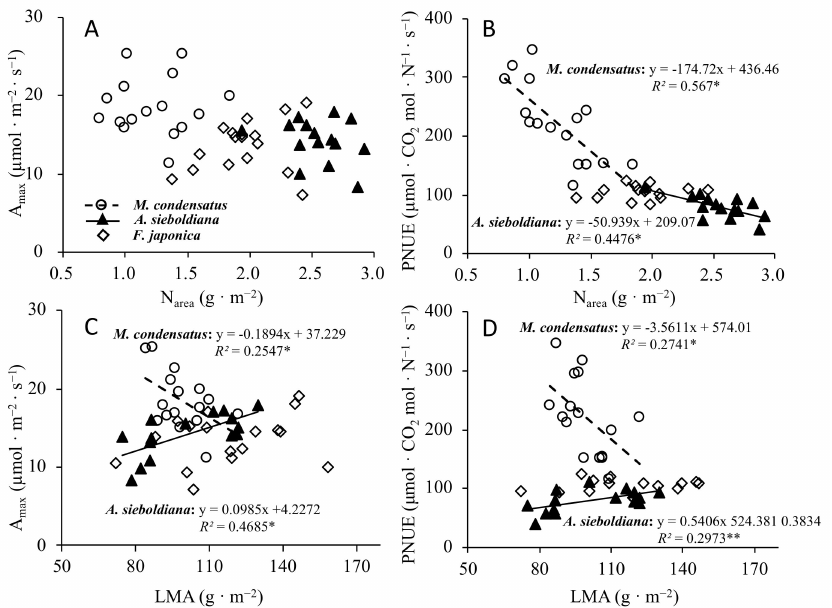
Figure 1. Relationships between leaf nitrogen concentration per leaf area (N area ) to light-saturated photosynthetic rate (A max ) ( A ) and photosynthetic N-use efficiency (PNUE) ( B ) and relationships of leaf mass per area (LMA) to A max ( C ) and PNUE ( D ) of three pioneer species on Miyake-jima volcano Island. Symbols: M. condensatus (open circles), A. sieboldiana (black triangle), F. japonica (open rhombus). Significant regression lines: M. condensatus (black dashed) and A. sieboldiana (solid). Significance of the regression lines: ns p > 0.05, * p < 0.05, ** p <